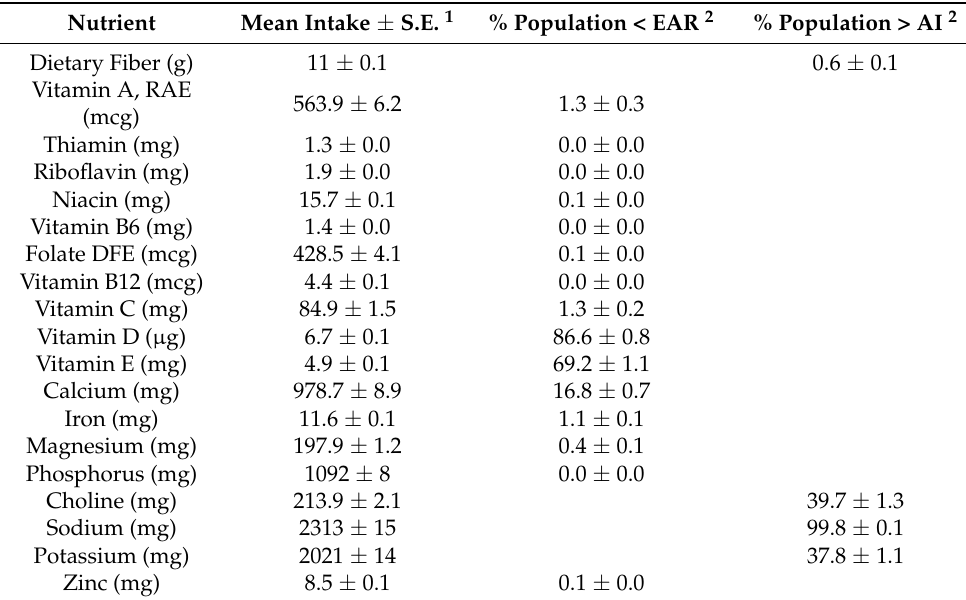
Table 2. Mean intakes of micronutrients for children 1–6 years and proportions not meeting Dietary Reference Intakes (NHANES